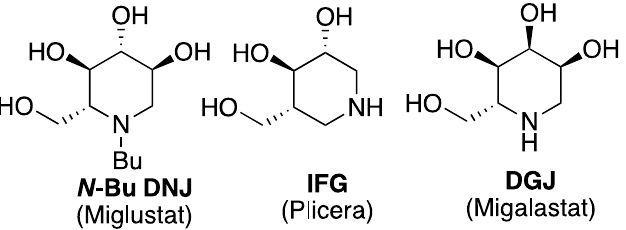
Figure 1. Examples of iminosugar therapeutic agents against LSDs.